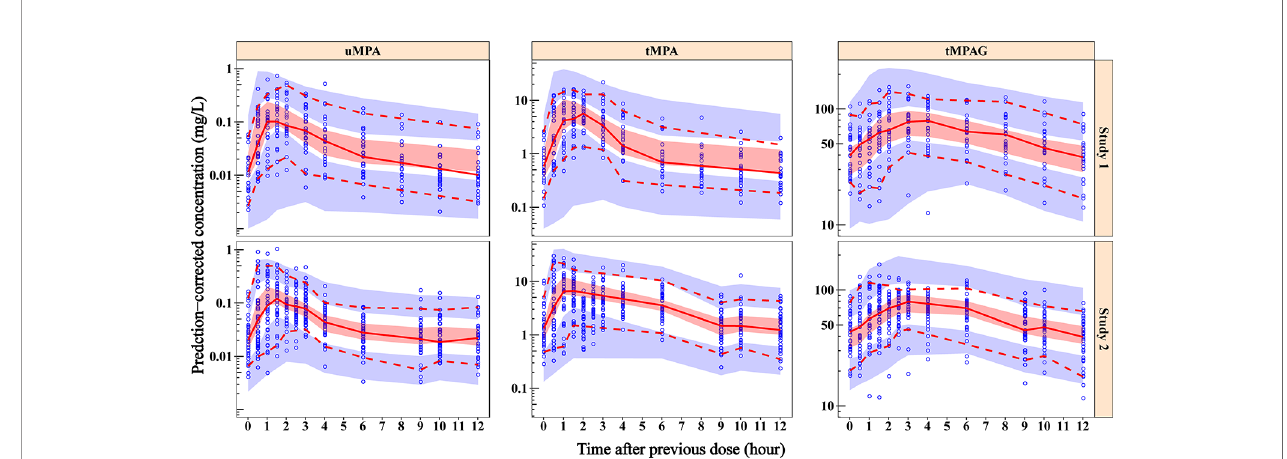
FIGURE 3 | Prediction-corrected visual predictive check plots of fi nal model for uMPA, tMPA and tMPAG. Blue dots represent the observed concentrations. Red solid lines represent the median of observations, and the semitransparent red fi elds represent the simulation-based 95% CIs for the median. The observed 5th and 95th percentiles are presented with red dashed lines, and the simulation-based 95% CIs for corresponding percentiles are shown as semitransparent blue fi elds. In general, the median, and 5th and 95th percentile lines of observations fall inside the area of the corresponding 95% CIs. Additionally, the majority of observed concentrations fall within the 90% prediction interval, which demonstrates that the predicted variability does not exceed the observed variability. CIs, con fi dence intervals; tMPA, total mycophenolic acid (MPA); tMPAG, total 7-O-mycophenolic acid glucuronide; uMPA, unbound MPA.